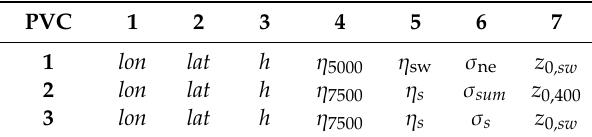
Table 4. Predictor variable combinations (PVC) yielding the highest coe ffi cients of determination in DS2 ( R 2 DS 2